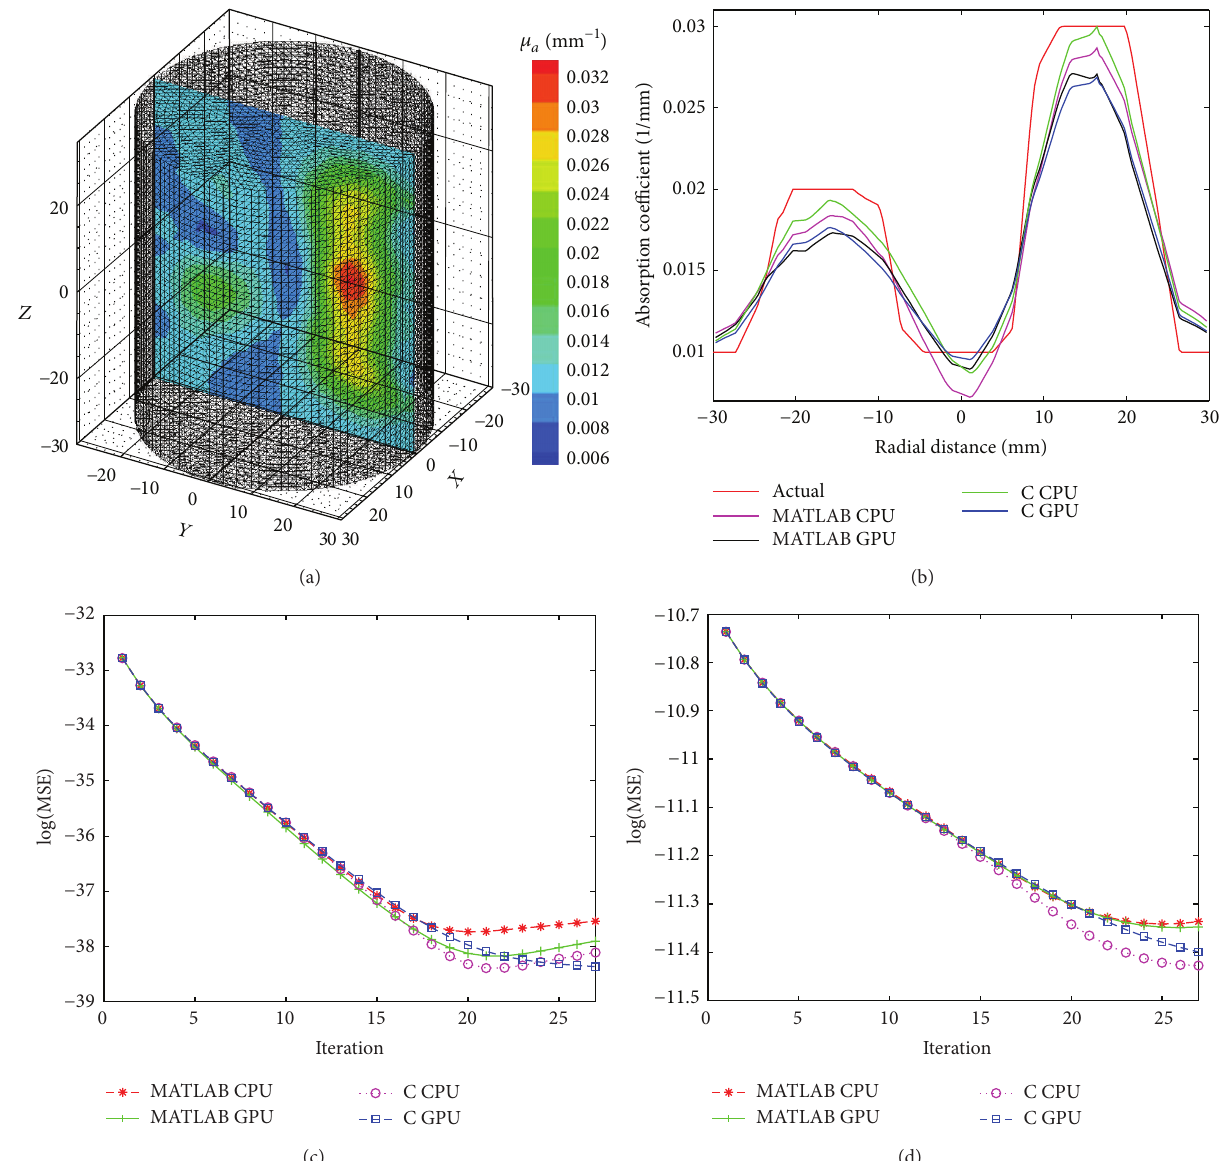
Figure 6: (a) Result of reconstruction of 3D images from 2% noisy data for simulation phantom, (b) cross-sectional line through the center of inhomogeneities 1 and 2, (c) MSE between 𝑀 𝐶 and 𝑀 𝐸 , and (d) MSE between 𝜇